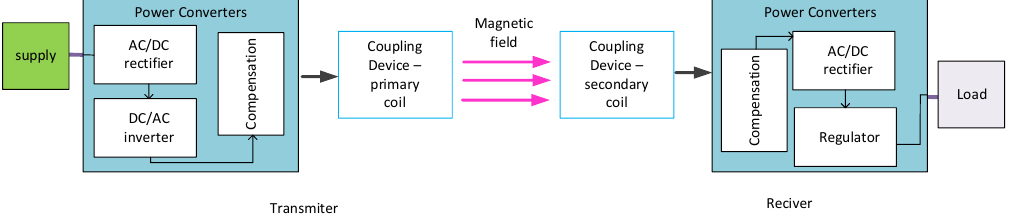
Figure 3. Wireless power transfer system — IPT.